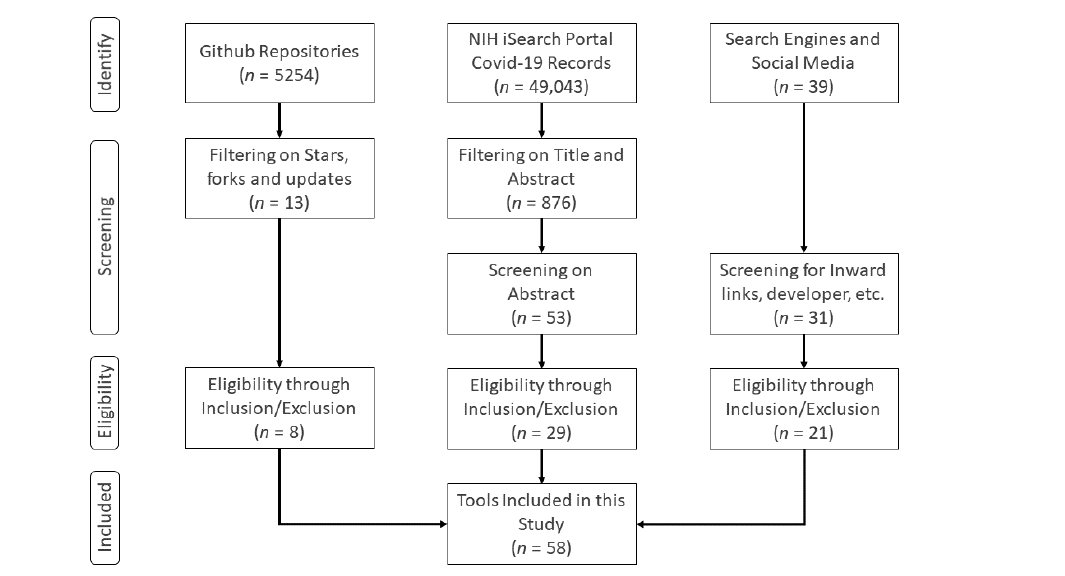
Figure 1. Diagram of systematic identification, screening, eligibility, and inclusion/exclusion of applications for selection in this